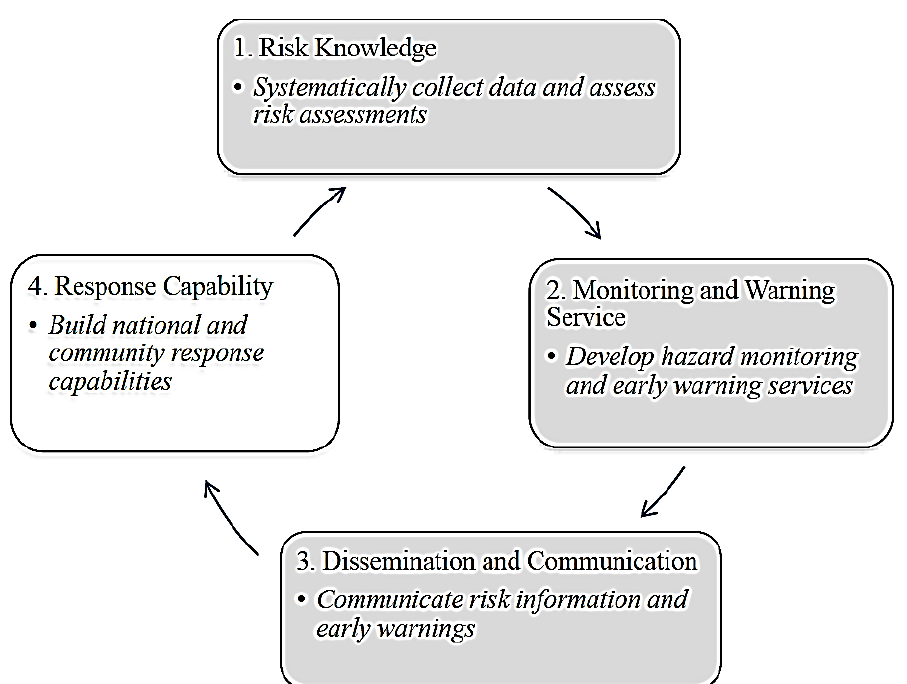
Figure 2. Elements of an Early Warning System .